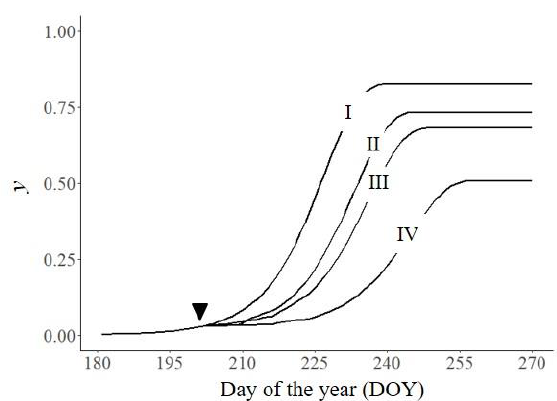
Figure 5. Effect on disease severity ( y ) of one treatment with protectant fungicides applied on DOY 202 ( ▼ ). I: untreated control, as in Figure 2; II: efficacy of 95% for 7 days; III: efficacy of 95% for 14 days; IV: efficacy of 70% for 14 days. Symbols are listed in Table 1.